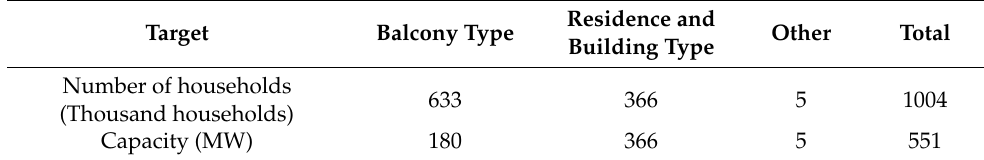
Table 1. The Plans for 1 million PV homes by 2022 [39].